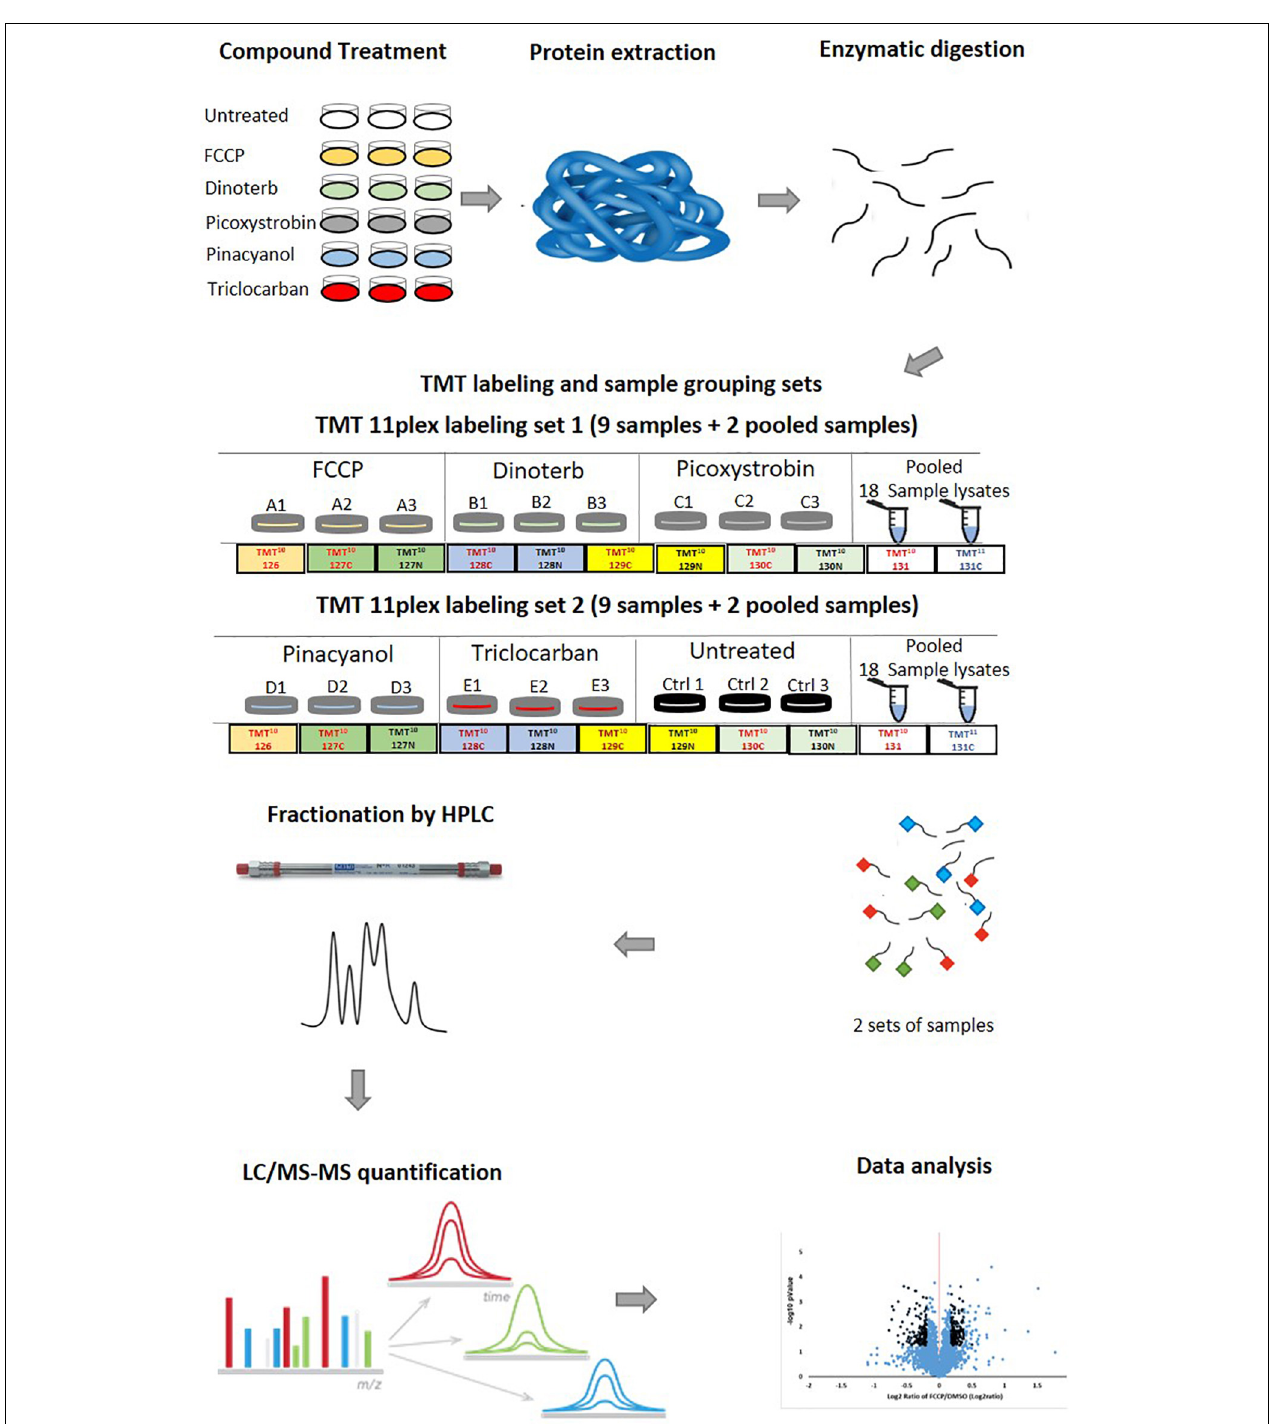
FIGURE 2 | A standardized mass spectrometry-based quantitative proteomic profiling workflow. The workflow includes the preparation of cell lysate, trypsin digestion, TMT 11-plex labeling of tryptic peptides, fractionation of labeled peptides by reverse-phase UHPLC, LC-MS/MS analysis, database search, quantification analysis and data analysis. Firstly, AC16 cells were treated with FCCP, dinoterb, pinacyanol, picoxystrobin and triclocarban at a single concentration around the identified IC 50 value. Each compound was tested in biological triplicates. Secondly, proteins from all 18 samples were extracted and digested after 18 h treatment. To accommodate the TMT-11plex labeling method, 18 samples were divided into two sets. Set 1 included samples treated with FCCP, dinoterb, and picoxystrobin. Set 2 included samples treated with pinacyanol, triclocarban, and untreated DMSO group. Each set contained two pooled samples containing all 18 individual samples as an internal control. Thirdly, the labeled peptides were separated by UHPLC and analyzed in LC-MS/MS. Lastly, the identified peptide was quantified and the proteomic dataset was analyzed in